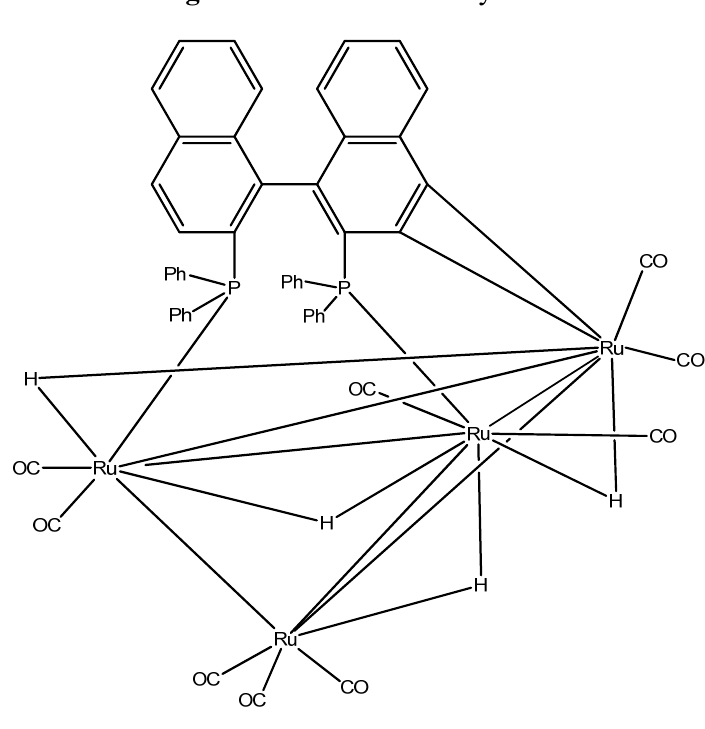
Figure 3. Ruthenium catalyst 14